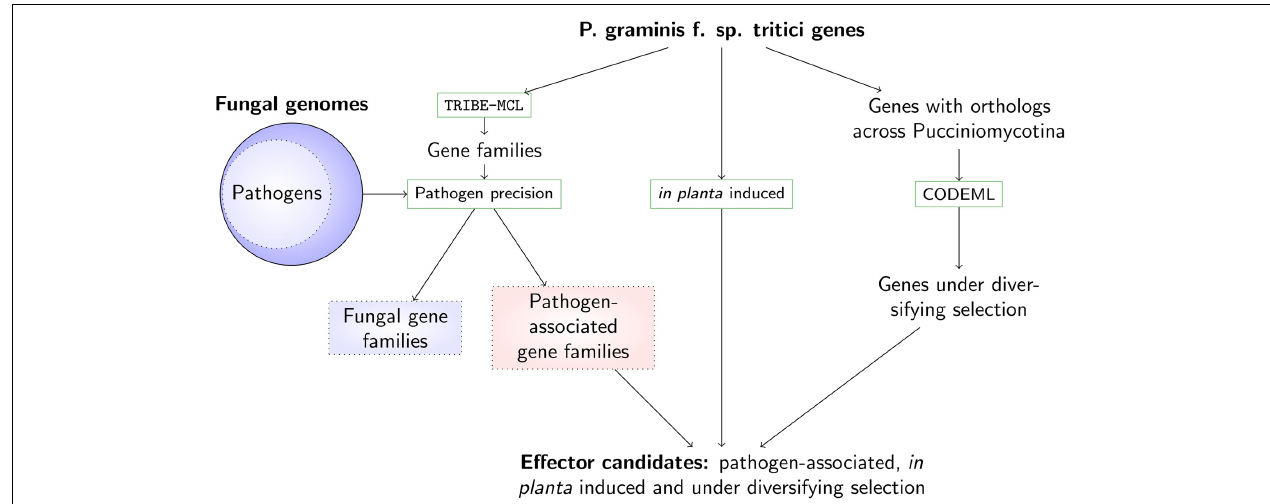
FIGURE 1 | A pipeline for predicting effector candidates in expanded pathogen genomes incorporating comparative analysis, expression data and evolutionary support. The stem rust genes are grouped into gene families using TRIBE-MCL (Enright et al., 2002) and then split into families associated with pathogenicity (including those that are specific to P. graminis f. sp . tritici ) and into fungal families, using